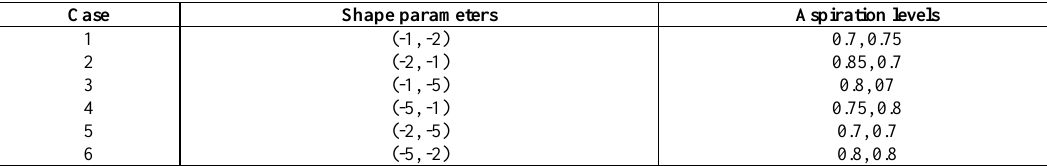
Table 2. Different cases by DM